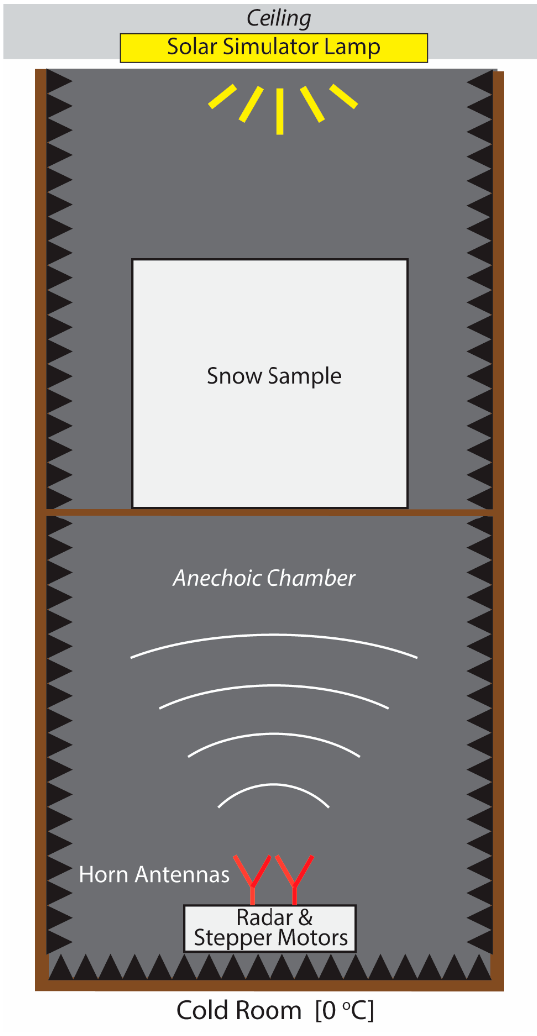
Figure 3. Schematic of laboratory snow melt experiments within an anechoic chamber inside of a cold room with continuous upward-looking polarimetric radar measurements. This study used a SensorLogic Onza ultra-wideband (UWB) radar development kit, which integrates the Novelda XeThru X4 radar technology onto a BeagleBone Black com- patible cape. The radar was configured to operate at a center frequency of 7.29 GHz (C-band) with a bandwidth of 1.5 GHz, such that the operating frequency range covered 6.54–8.04 GHz. The radar unit was configured in a quasi-monostatic configuration con- sisting of two linearly polarized 15 dBi gain horn antennas (WR-137) designed to operate between 5.85 and 8.20 GHz. The far field radiation pattern of the antennas, defined by the Fraunhofer distance [26], was 43 cm, and the bottom of the snow sample was also in this region. To collect four polarimetric measurements (VV, HH, VH, HV), the two antennas were mounted 11 cm apart on a custom-built stepper motor assembly that automatically rotated the antennas through precise 90 ◦ rotations between each radar acquisition, such